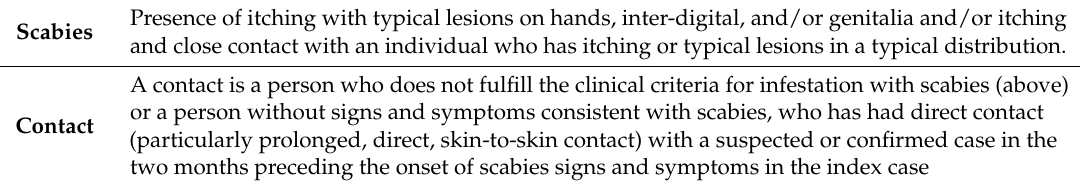
Table 1. Clinical case definition of scabies and contact